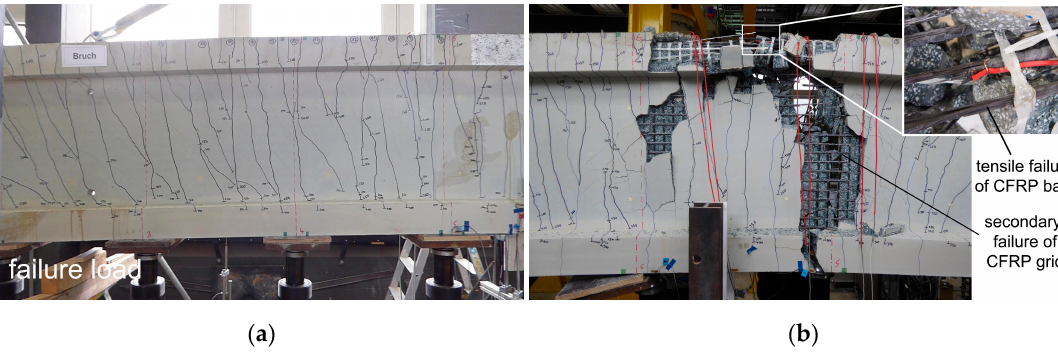
Figure 8. Failure of FT01: ( a ) beam at peak load 0.24 s prior to failure; ( b ) ruptured CFRP bars and secondary rupture of grid reinforcement with spalling of concrete.